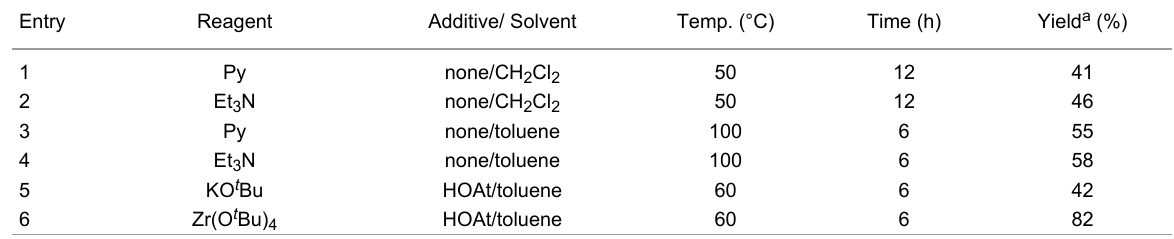
Table 2: Lactamization under different reaction conditions to obtain 1 and 2.